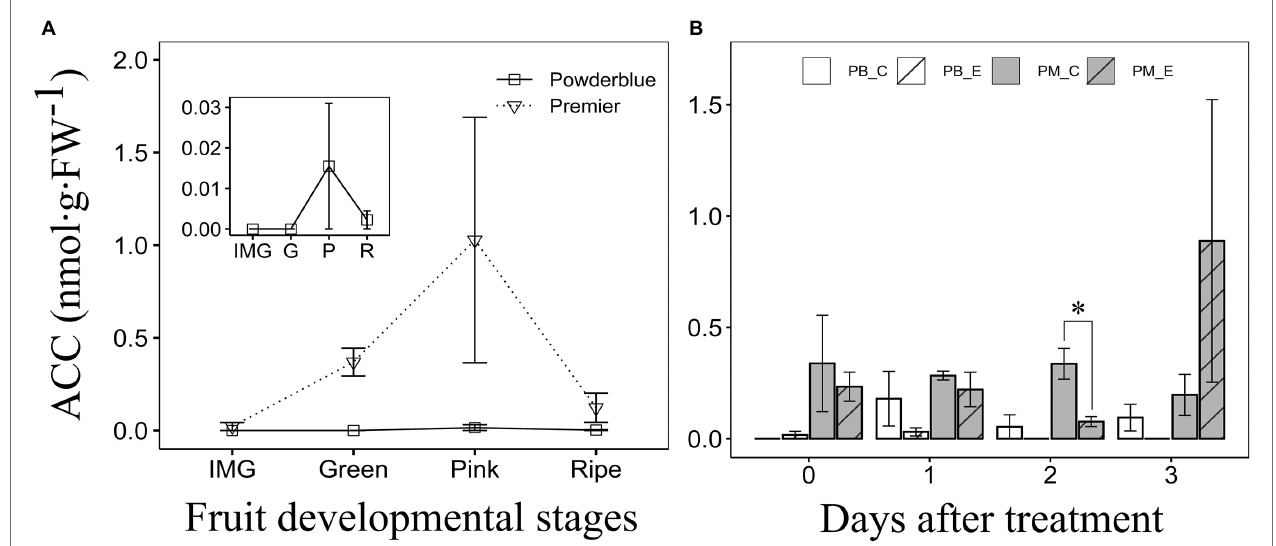
FIGURE 3 | Concentration of 1-aminocyclopropane-1-carboxylic acid (ACC) during fruit ripening (A) and after treatment with water (Control) and 250 ppm ethephon in “Premier” and “Powderblue” (B) . Inset shows ACC concentration in “Powderblue” (A) . IMG, immature green; G, Green; P, Pink; R, Ripe; PB_C, Powderblue control; PB_E, Powderblue ethephon; PM_C, Premier control; and PM_E, Premier ethephon. No significant differences in ACC concentration across fruit developmental stages in a given cultivar were detected using ANOVA. Data represent mean ± SE. Asterisk indicates that the means are significantly different between treatments (control and ethephon), within a genotype at a given stage, according to t -test ( α =